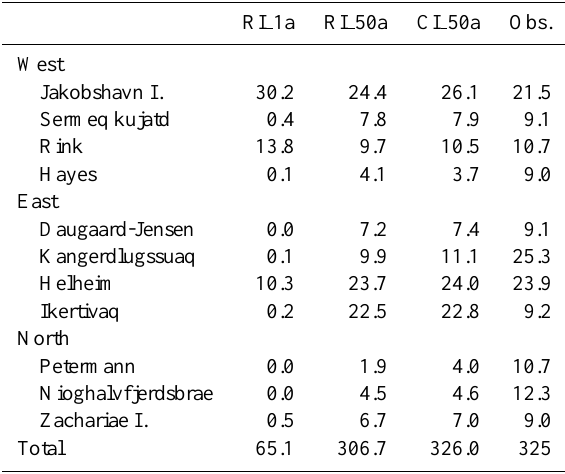
Table 2. Model discharge for individual outlets and the whole ice sheet in Gta − 1 : after 1yr (RI 1a) and after 50yr (RI 50a) of sur- face relaxation with the Robin inverse method, after 50yr of surface relaxation with the control inverse method (CI 50a), and observa- tions from 1996 (or 2000 when not available, and converted from km 3 a − 1 to Gta − 1 using a uniform density of 910 kgm − 3 for ice) (Rignot and Kanagaratnam, 2006)